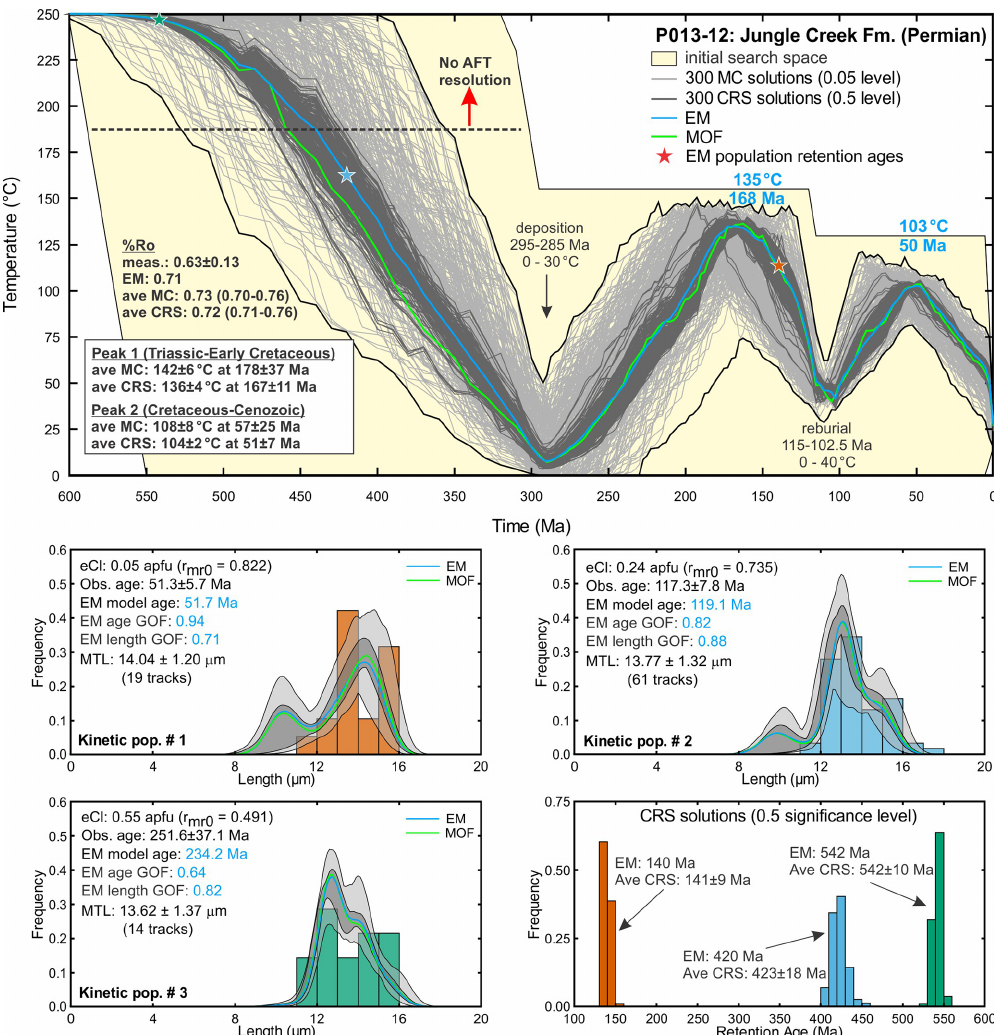
Figure 6. The upper panel shows AFTINV thermal-history results for the Permian sample. Light grey lines are statistically acceptable Monte Carlo solutions ( ≥ 0 . 05 significance level), and dark grey lines are good solutions ( ≥ 0 . 5 level). The black curves bounding model solutions are not valid solutions. The blue curve is the exponential mean (EM) of the 300 good solutions, and the green curve is the closest fitting minimum objective function (MOF) solution. The lower panels show model and observed track length distributions and the distribution of model retention ages (age of oldest track) for the different kinetic populations. The goodness of fit (GOF) probability for the age and length data is given for the exponential mean solution. Uncertainties in average retention age, average peak temperature, and average peak time are 2 standard